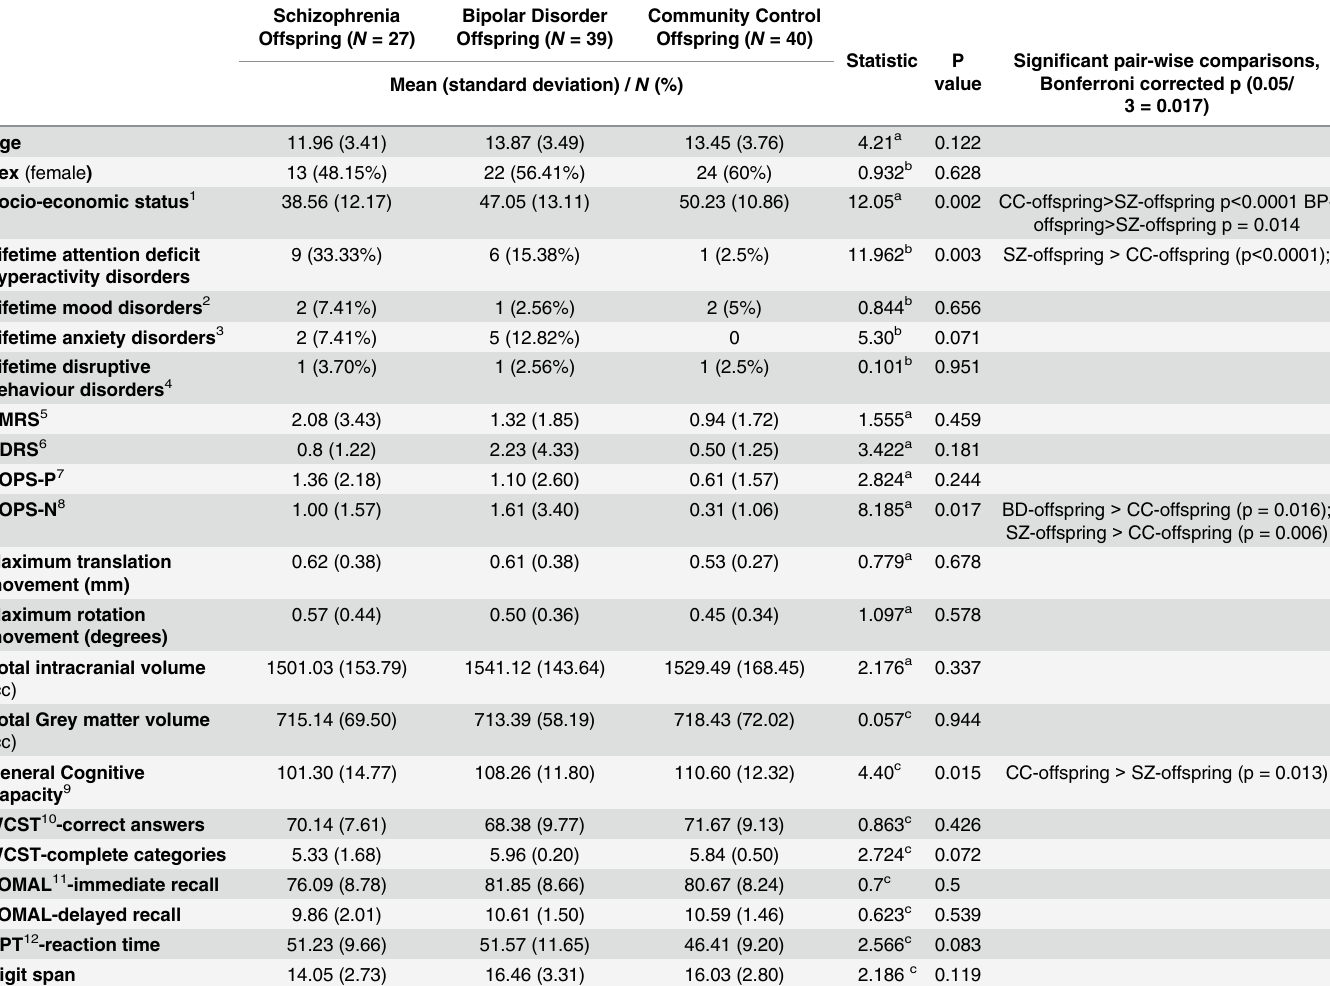
Table 2. Socio-demographic, clinical and cognitive characteristics of the